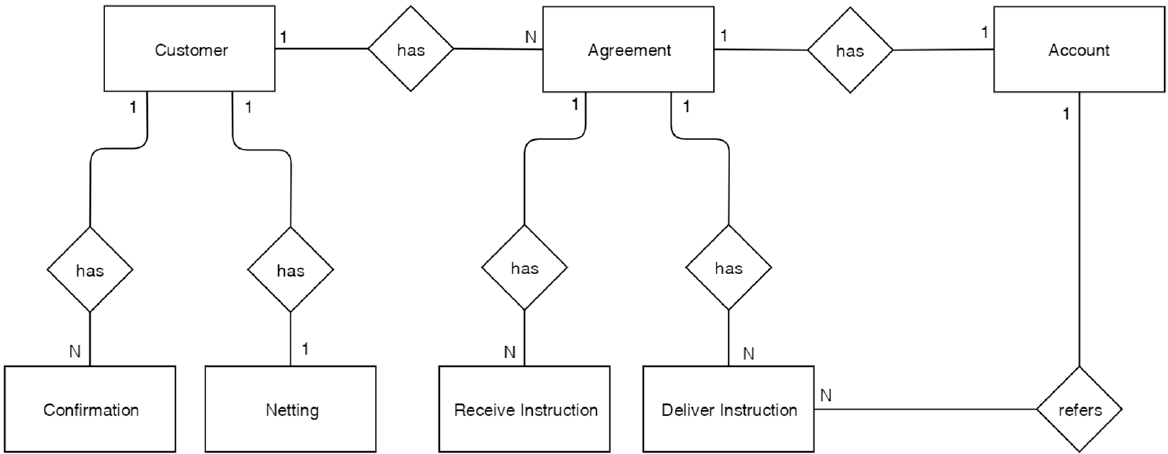
Figure 13. The simplified conceptual schema of the SSI application.